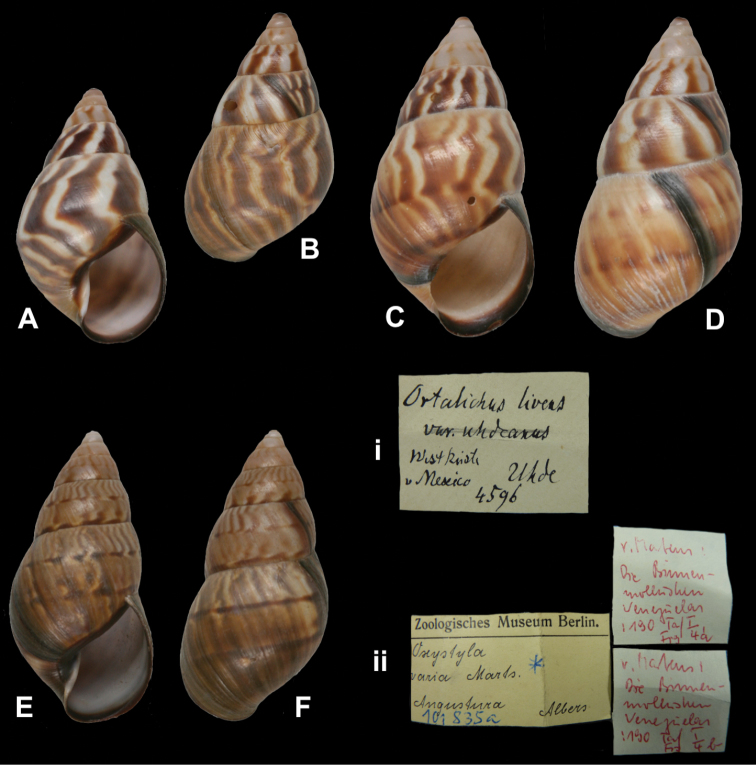
Orthalicus species A–D
Orthalicus uhdeanus Martens, 1893 A–B, i syntype ZMB 4995 (H = 39.3) C–D syntype ZMB 4996 (H = 54.3) E–F, ii
Orthalicus varius Martens, 1873, syntype ZMB 101835a (H = 47.2).